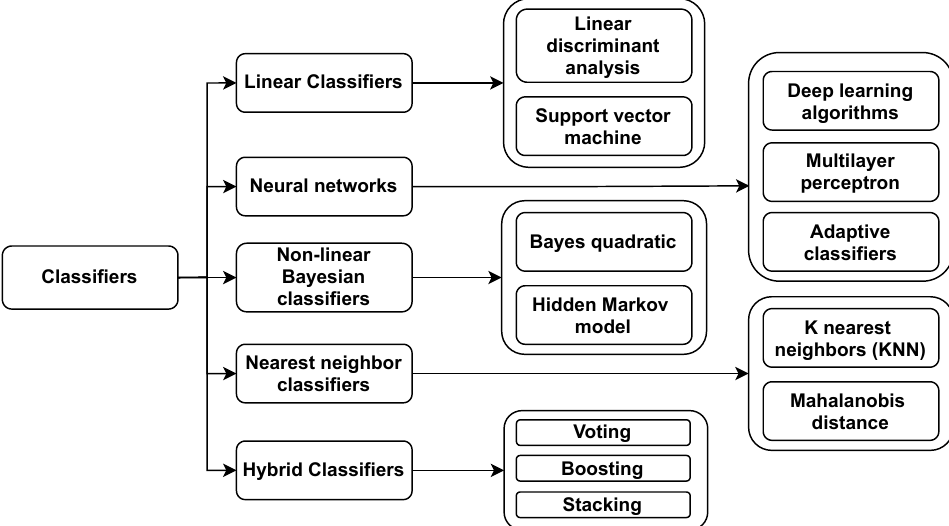
Figure 6. Classification of commonly used classifiers in